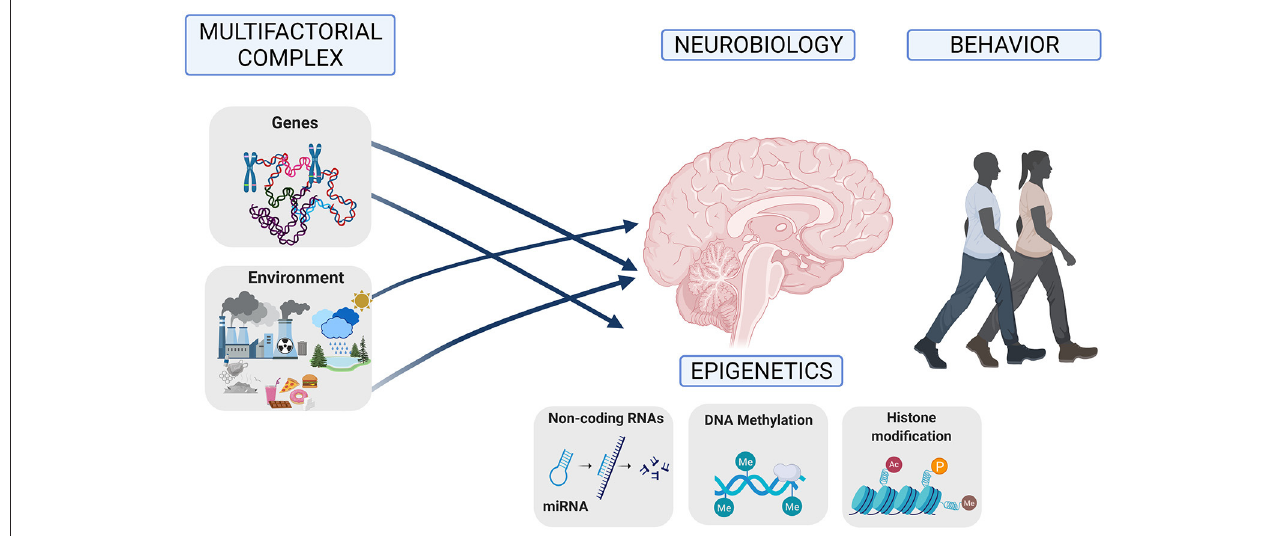
FIGURE 1 | Psychiatric disorders have a complex multifactorial origin with an interaction between multiple genes and multiple environments that influence neurobiology and modify epigenetics during development and adulthood, influencing